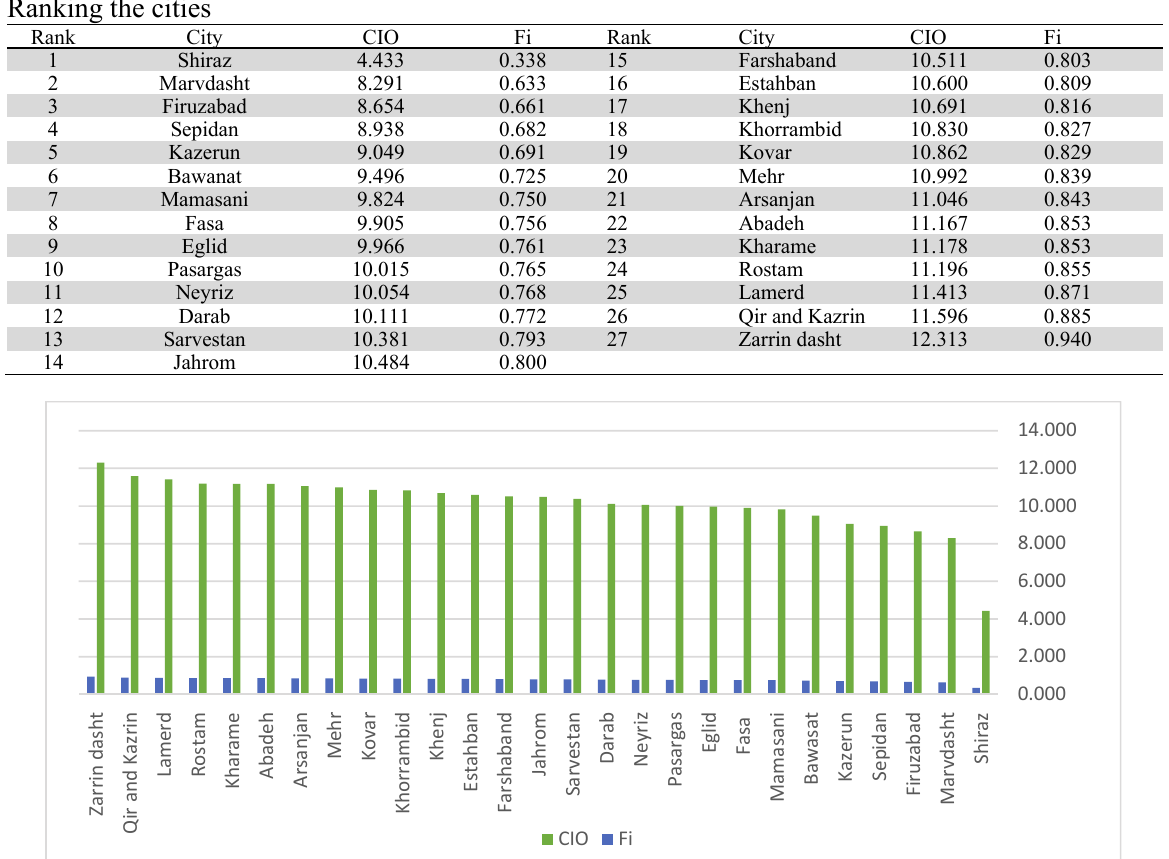
Fig. 3. The ranking of the cities with potential of tourism investment in the Fars